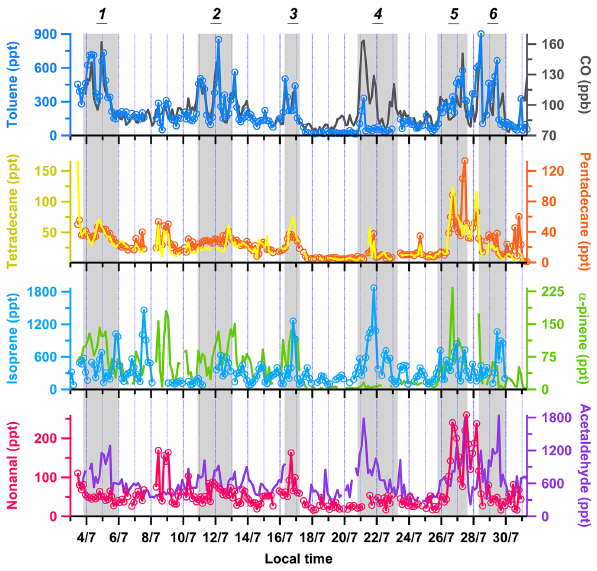
Figure 3. Summertime time series of carbon monoxide, toluene, tetradecane, pentadecane, isoprene, α -pinene, nonanal and acetalde- hyde. The grey-shaded areas highlight the “Atlantic Polluted” wind regimes associated with stagnant conditions and increased